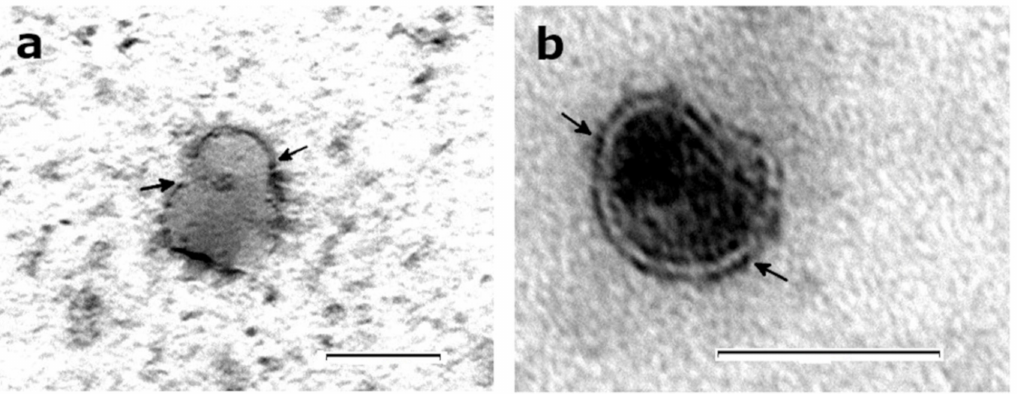
Figure 3. Exosomes were isolated from bovine milk according to the proposed method, and stained with antibodies ( a ) CD63 and ( b ) HSC70, coupled with a 10-nm gold particle. Images were taken using magnification 25,000× [( a ), scale bar 200 nm] and 92,000× [( b ), scale bar 100 nm].